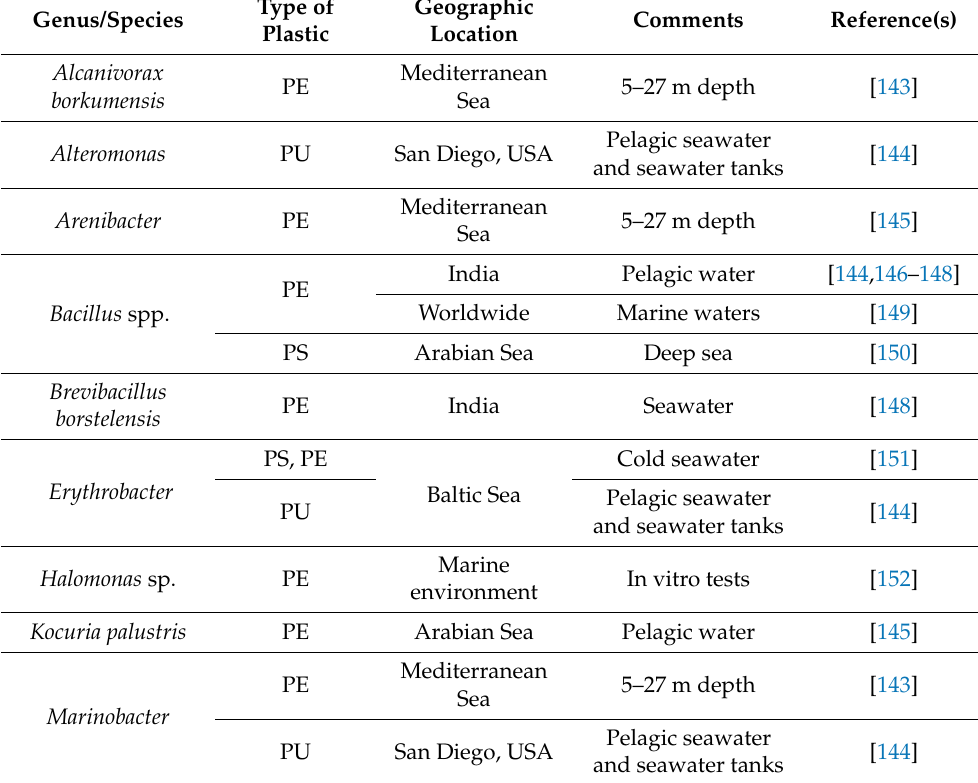
Table 1. Putative plastic-degrading microorganisms detected in the marine plastisphere.